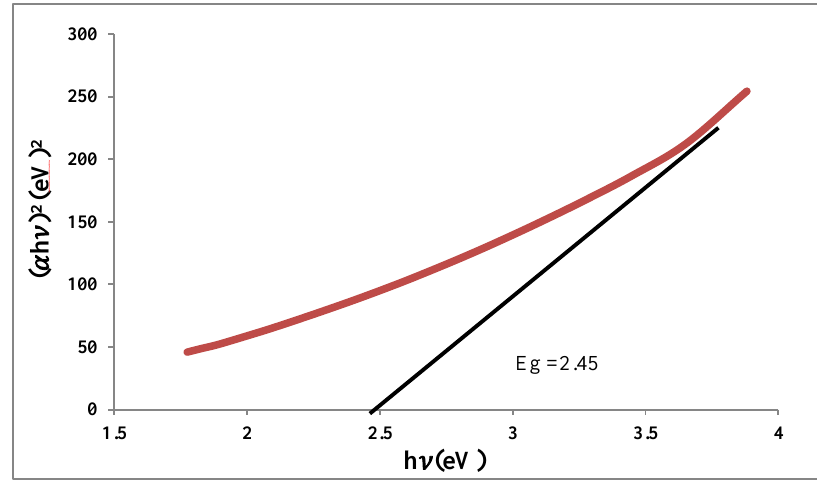
Figure 11. Plot of ( 𝛼 h 𝜈 ) ² against h 𝜈 for LaFeO ₃ prepared by sol-gel method sintered at 900